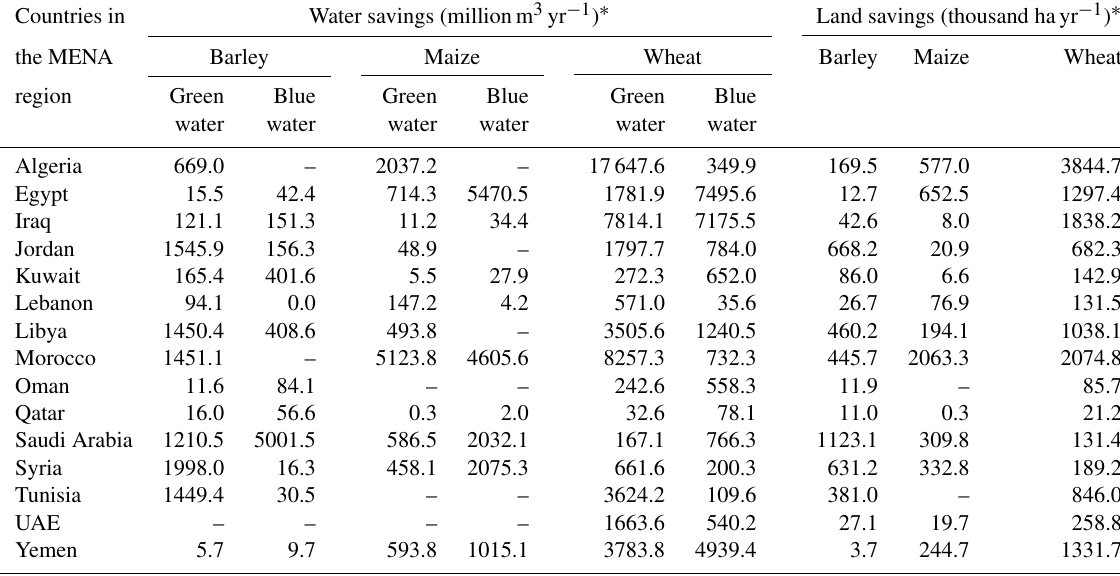
Table 3. The annual water and land savings based on imported crops in the MENA region from 2000 to 2012. Countries